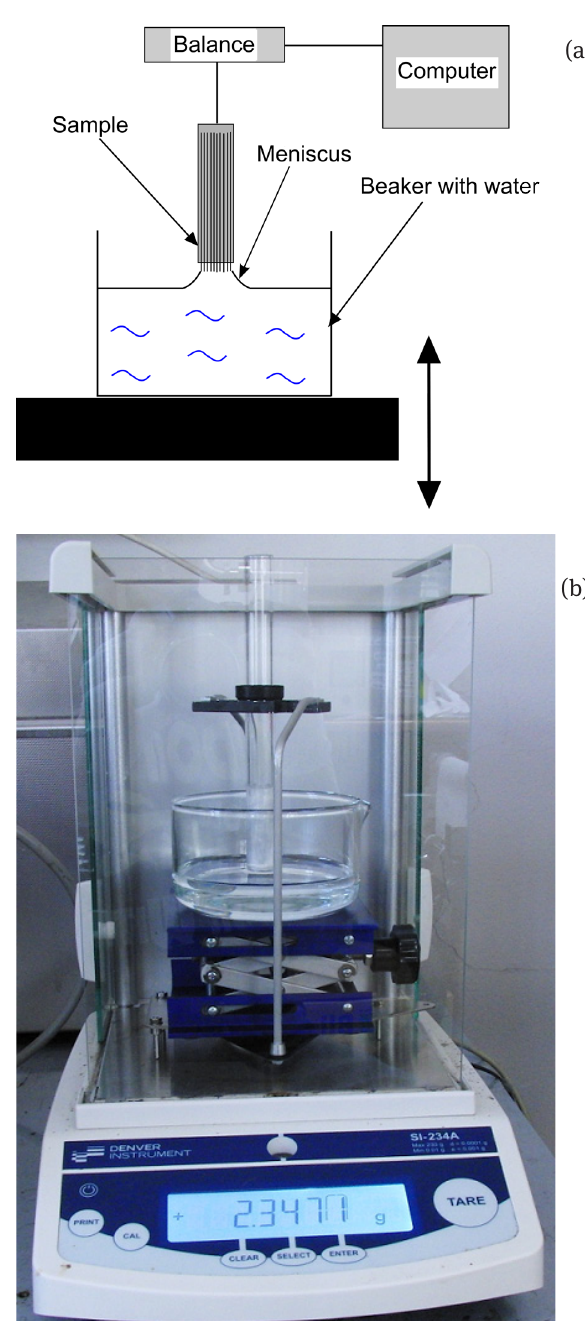
Figure 4: a) The experimental setup for measurement of wetting of PP fibres by experimental liquid. b) Analytical balance DENVER INSTRUMENT SI - 234A with the sample and adjustable table with liquid